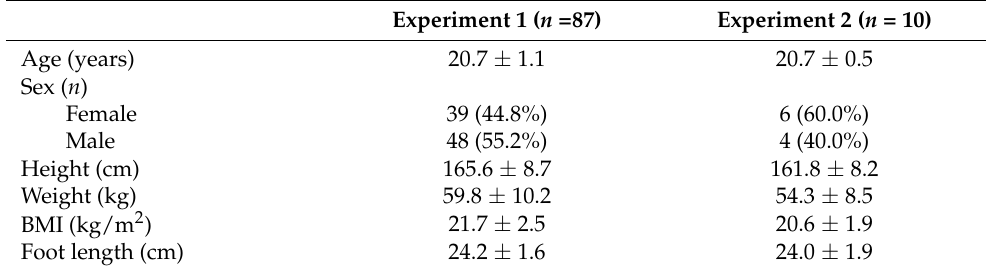
Table 1. Characteristics of the